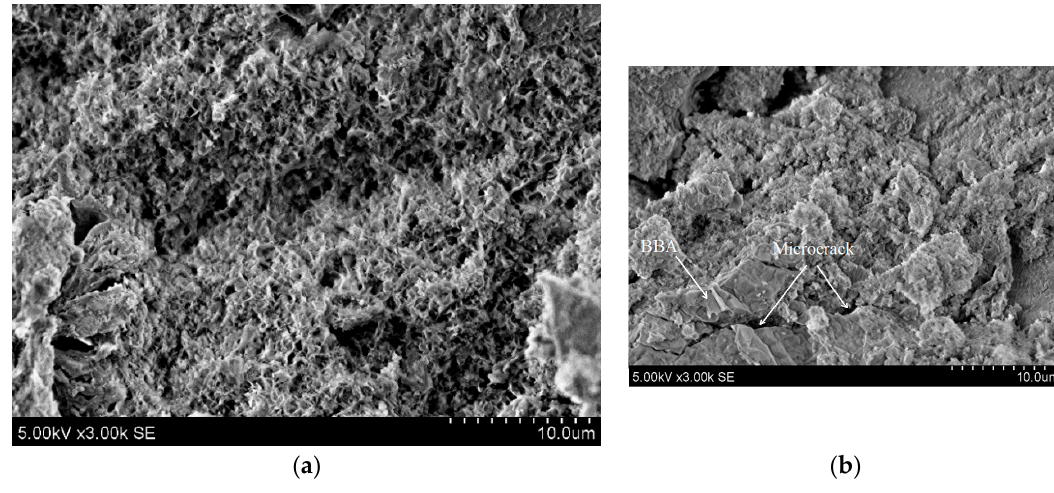
Figure 6. Microstructure of alkali activated biomass bottom ash samples ( a ) PG 15-3 and ( b ) PGWG 15-3.